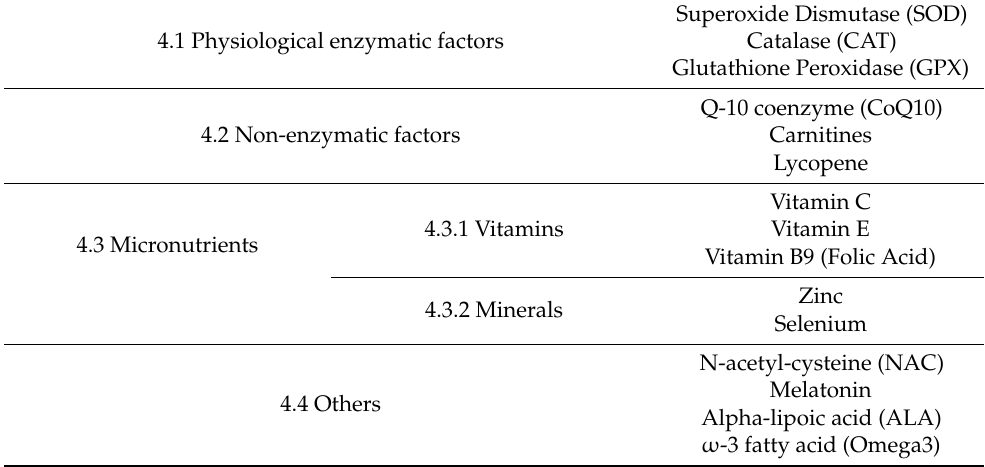
Table 1. Antioxidants related to male fertility by biological